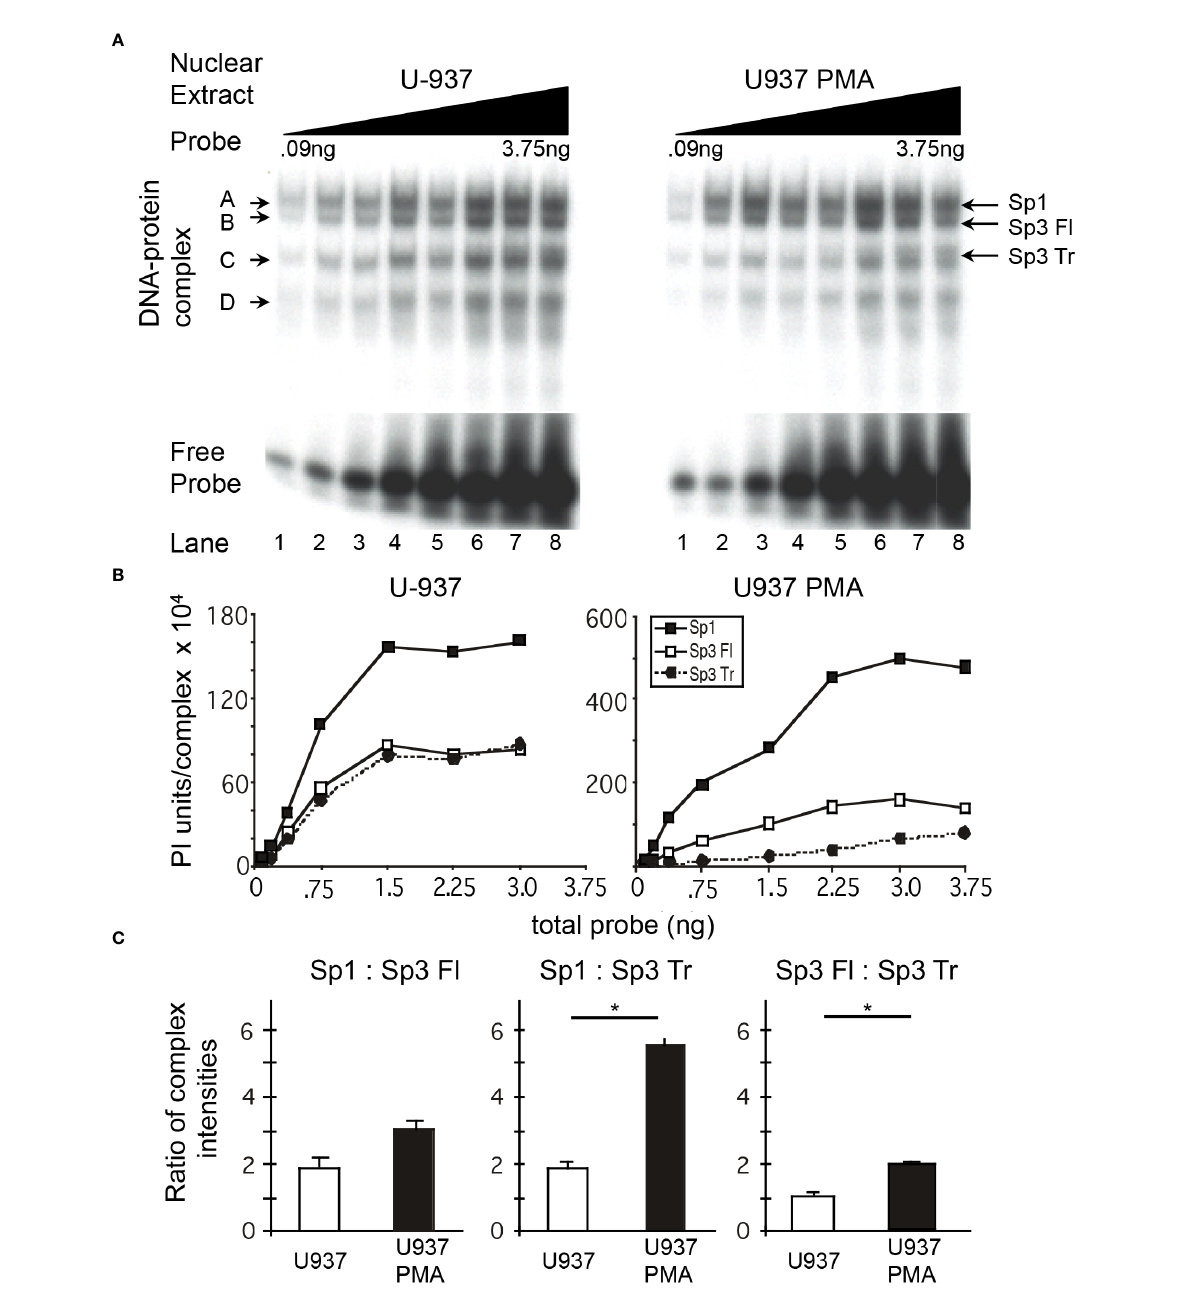
FIGURE 4 Relative levels of Sp factor binding in the monoblastic U-937 cell line varies with the addition of the chemical differentiating agent, PMA. Relative Sp factor binding was examined by EMS probe titration analyses. (A) Untreated and PMA-treated U-937 nuclear extracts (6 m g) were reacted with increasing amounts of labeled HIV-1 Sp site III probe (12,500 to 500,000 cpm; 0.09 to 3.75 ng). Complexes were separated by a 2-hr electrophoresis interval through a 4% acrylamide gel to retain unbound probe to facilitate subsequent analysis. DNA-protein complexes are labeled A through D; arrows indicate the position of low mobility Sp-related complexes. Representative image shown. (B) Untreated and PMA-treated U- 937 nuclear extracts (6 m g) were reacted with increasing amounts of labeled HIV-1 Sp site III probe (12,500 to 500,000 cpm; 0.09 to 3.75 ng). Complexes were subjected to a 3-hr electrophoresis interval utilizing 4% acrylamide to allow for greater separation and a more accurate subsequent quantitation of the resulting DNA-protein complexes. Unbound probe was not retained. DNA-protein complexes were quantitated and graphed as phosphorimager units per complex. Representative graph shown. (C) DNA-protein complex intensities (B) were averaged at saturation and their relative levels compared within a given gel. This process was repeated three times and the average of the three relative intensities was graphed for each pair of DNA-protein complexes examined: Sp1 relative to Sp3 Fl, Sp1 relative to Sp3 Tr, and Sp3 Fl relative to Sp3 Tr. Comparisons between all were evaluated by the quantitative two-tailed student t-test and p < 0.05 was considered signi fi cant